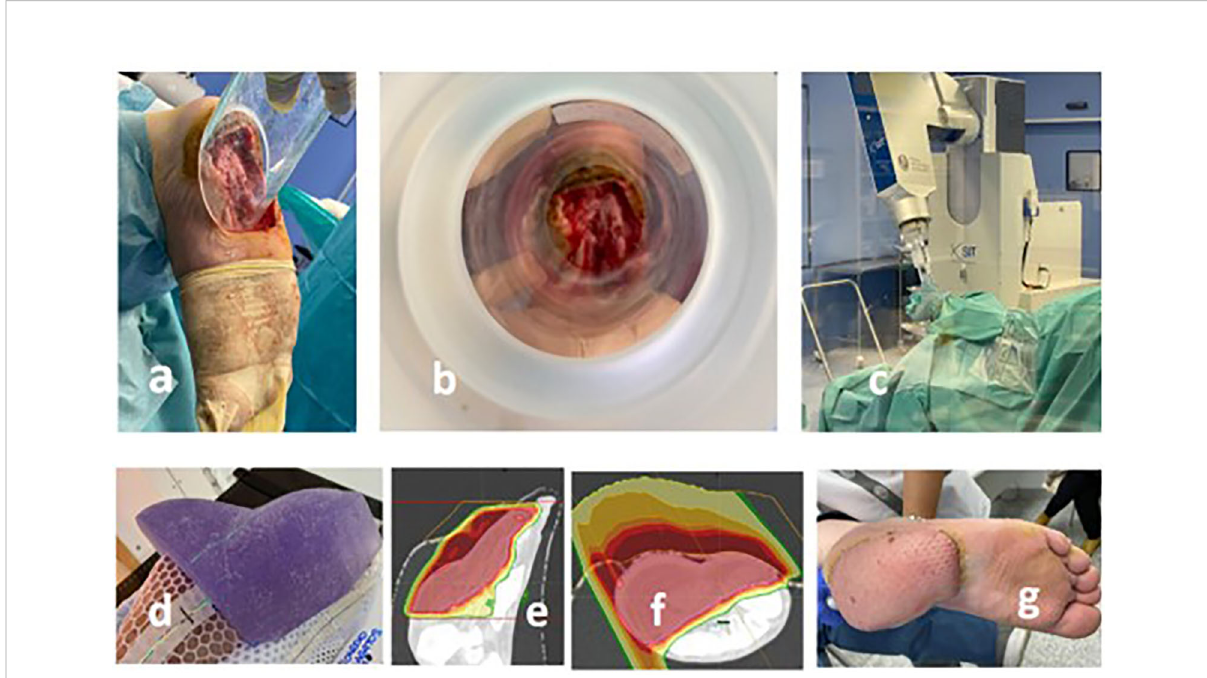
FIGURE 1 Recurrent plantar melanoma of the right foot treated with a combination of IOeRT and proton therapy. (A) Applicator positioning to encompass the post-resection bed including involved margins and the area at high risk for recurrence (skin is protected; key structure for the viability of the fl ap-repair maneuver). (B) Beam ’ s eye view of the target. (C) Linear accelerator and surgical room arrangement (notice the use of a beam- stopper). (D) Individualized bolus for proton therapy. (E, F) Dosimetric performance of the proton pencil beam. (G) Outcome of the myocutaneous fl ap employed for